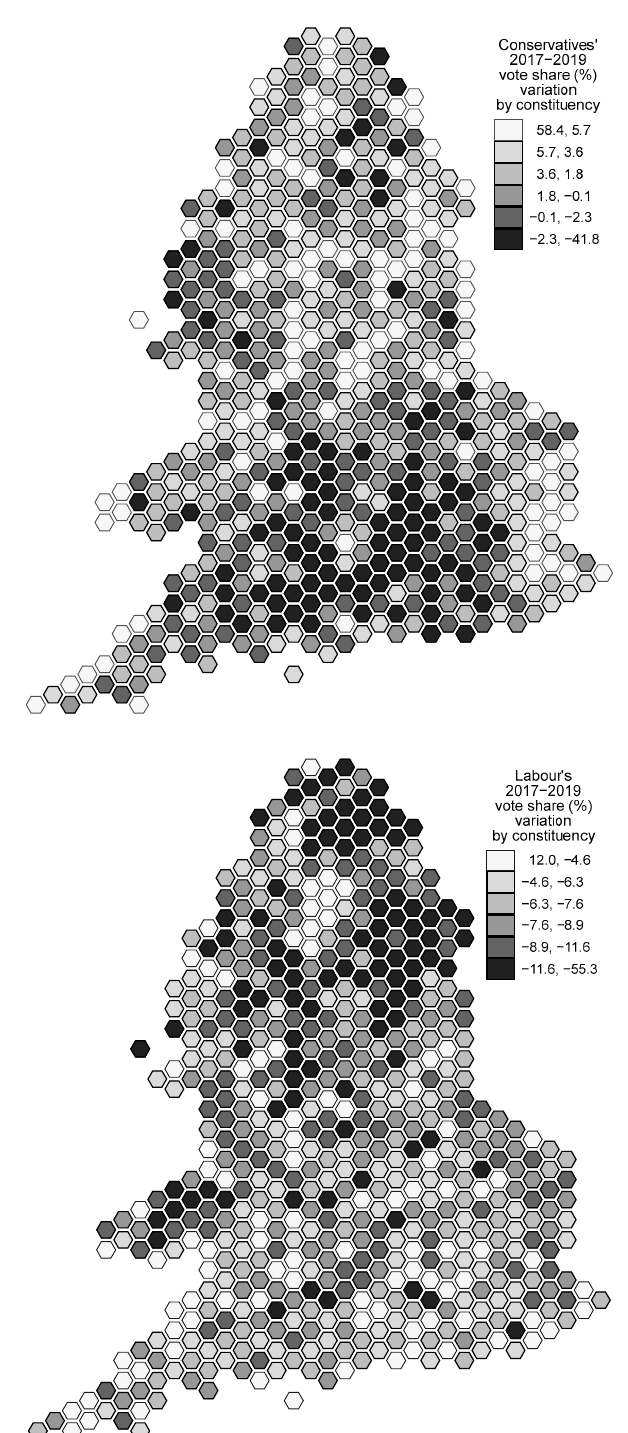
Figure 1. Labour’s and Conservatives’ vote share variations between the 2017 and 2019 general elections, by England and Wales’ constituency (equal classes): normalised geography maps by equal-area hexagons. Maps created by the author. Source: data from the UK House of Commons Library: https://commonslibrary.parliament.uk/constituency-data-election-results/, accessed on 12 July 2020.